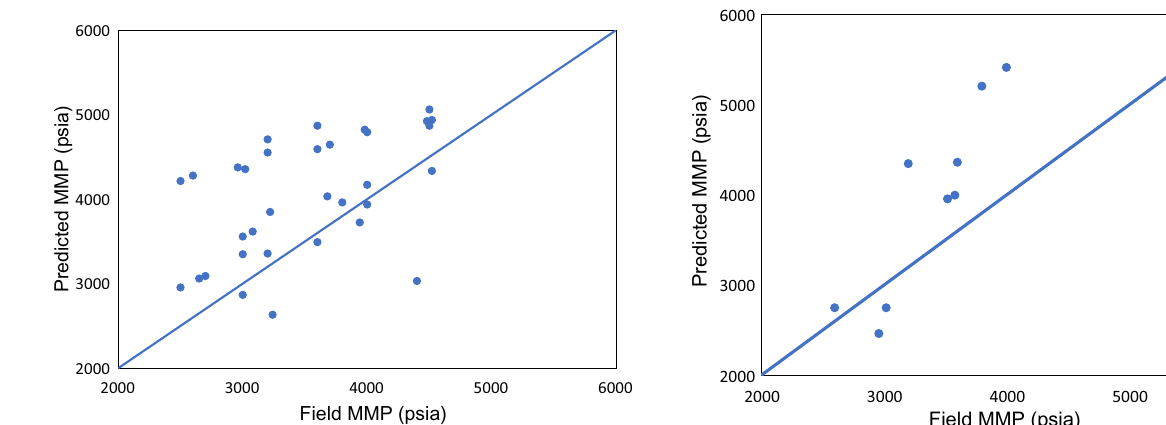
Fig. 5 Cross-plot of MMP training data for Firoozabadi and Aziz (1986) correlation